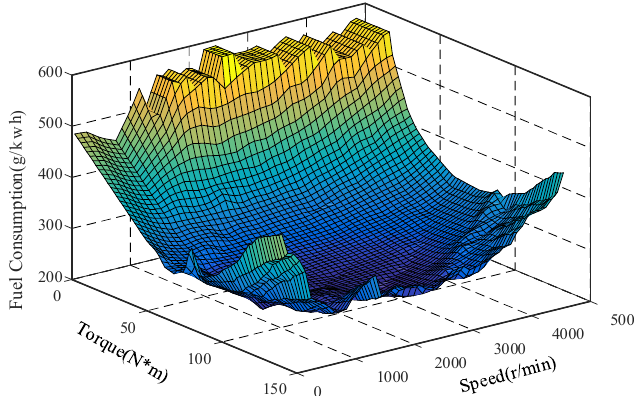
4 of 18 Table 1 . Main parameters of the PHEV. Parameters